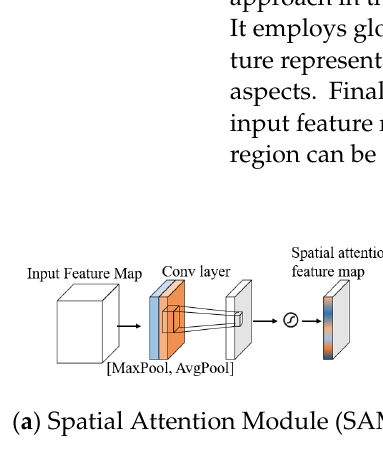
where ⊙ is the Hadamard operator; bedding the SAM.